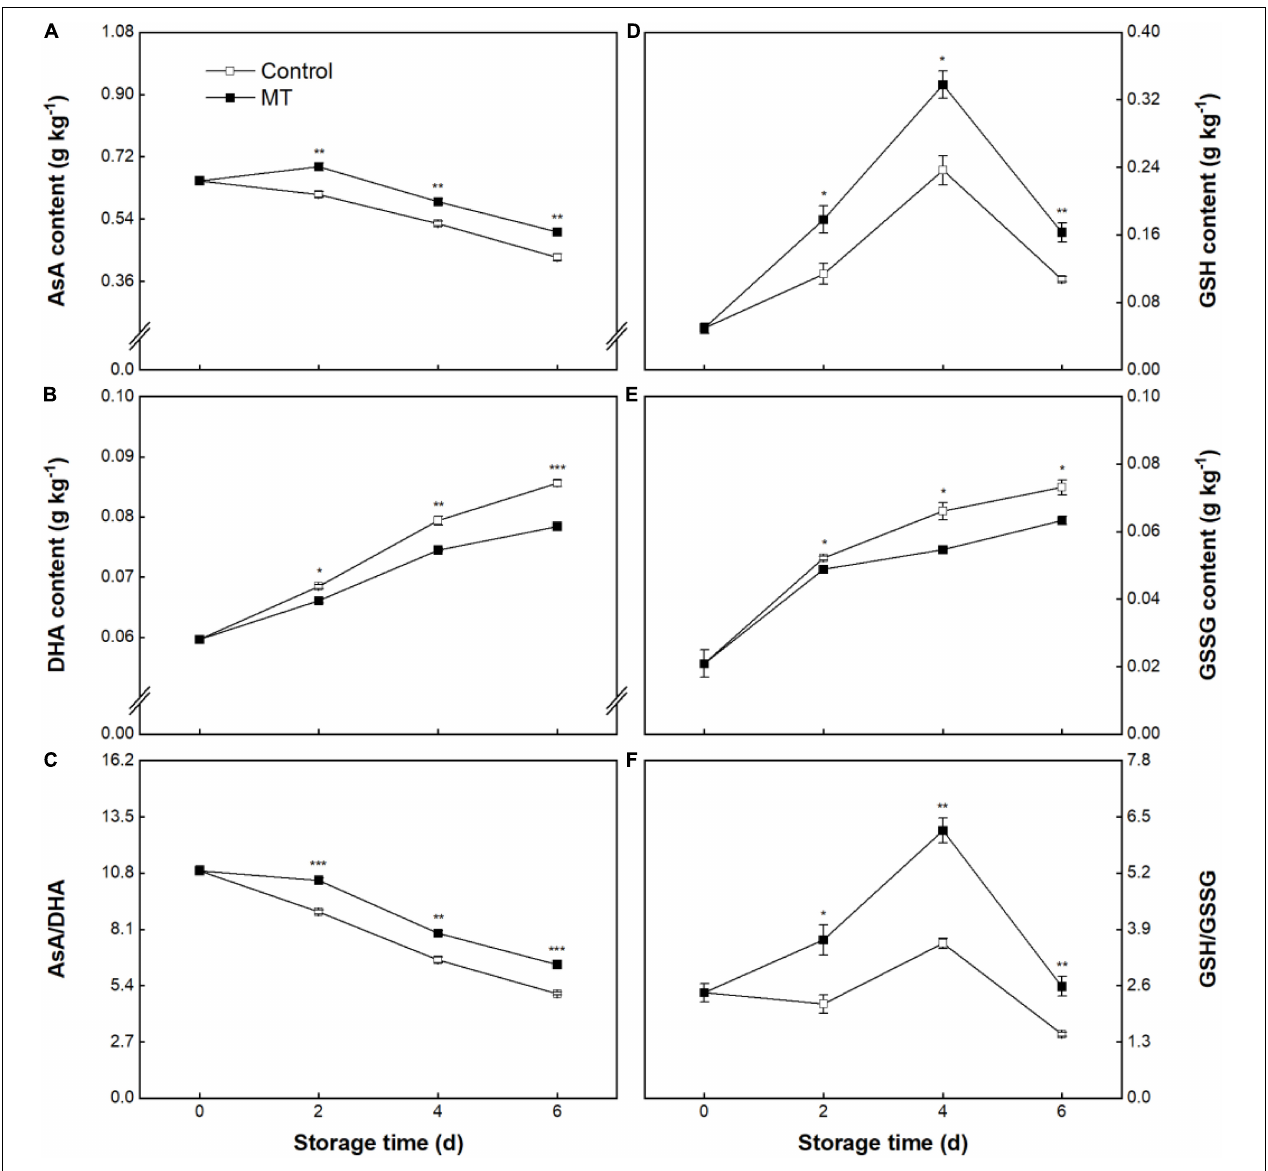
FIGURE 7 | Ascorbic acid (AsA) (A) and dehydroascorbate (DHA) (B) contents, AsA/DHA ratio (C) , glutathione (GSH) (D) and oxidized glutathione (GSSG) (E) contents, and GSH/GSSG ratio (F) in “Baoyan 7” rambutan fruit during storage at 25 ◦ C after treatment with 0.125 mmol L − 1 MT or water (control). The vertical lines represent the SE of triplicates while the asterisks indicate a significant difference between the MT group and the control group on the same day (* p < 0.05, ** p < 0.01, and *** p <